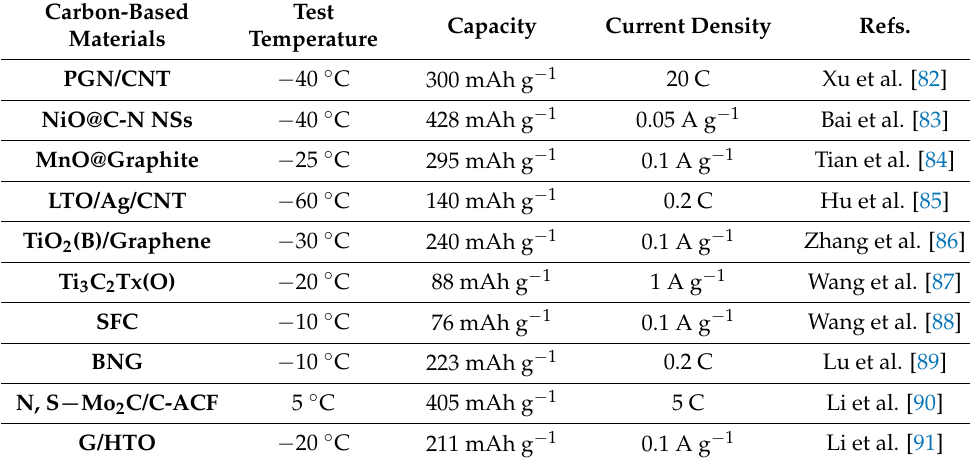
Table 1. Modified carbon-based materials for low-temperature